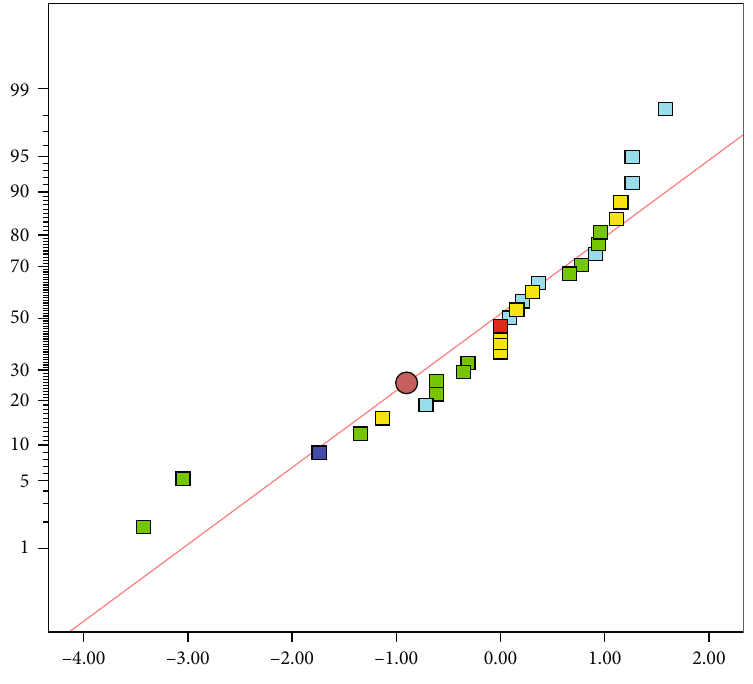
Figure 6: Normal probability